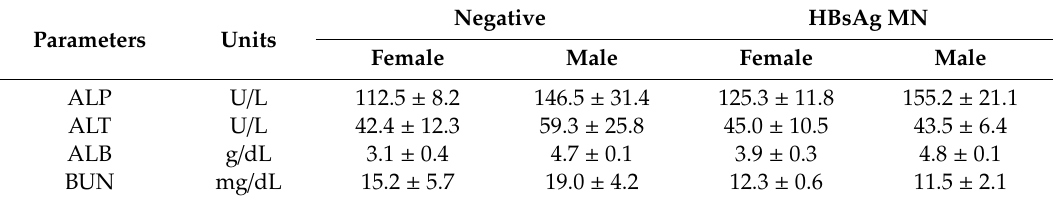
Table 1. Serum biochemistry parameters in female and male rats treated with HBsAg MNs ( n = 3).